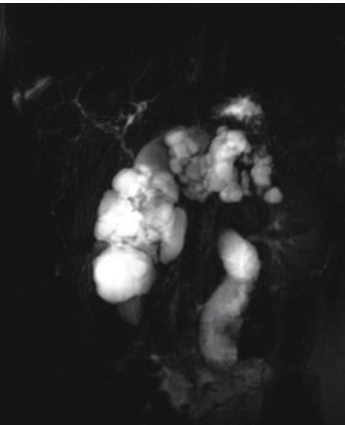
Figure 3: MRCP. T2-weighted MR image—HASTE (Half-Fourier Acquisition Single-Shot Turbo Spin Echo) sequence—demonstrates complete replacement of the pancreas by multiple cysts of variable size with thin and smooth walls. There is no communication of cysts with pancreatic ducts.